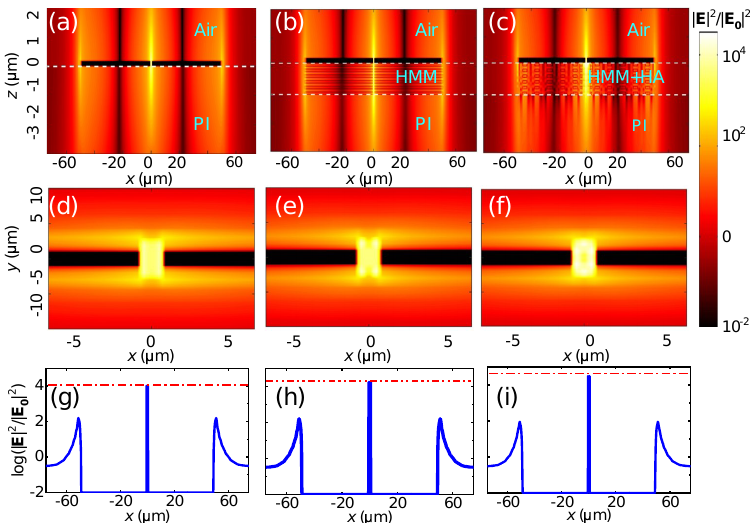
Figure 2. Comparison of three configurations on electric field intensity enhancement. ( a , d , g ) The gold dipolar antenna sits on the PI substrate directly. The antenna and the substrate is buffered by ( b , e , h ) the HMM composed of the multilayer structure, or ( c , f , i ) by the HMM with hole array structure. ( a – c ) side view at y = 0, ( d – f ) top view at z = 1.2 µ m, and ( g – i ) line view at y = 0 and z = 1.2 µ m. The red horizontal lines indicate the value of field enhancement in the